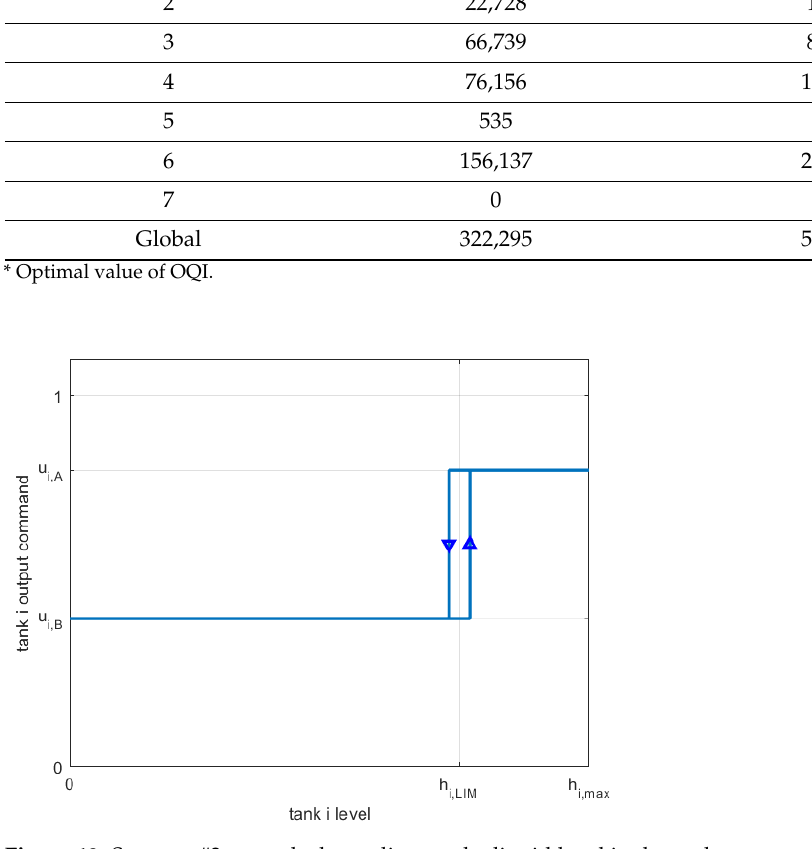
Figure 14. Strategy #3 chromosomal structure. 3.4.1. Volume of Overflow Minimization (Strategy #3) Characteristics: fitness function: V (cid:2925)(cid:2932)(cid:2916) ; the algorithm stopped after 100 generations. Figure 15 shows the best and the average fitness of each of the generations.